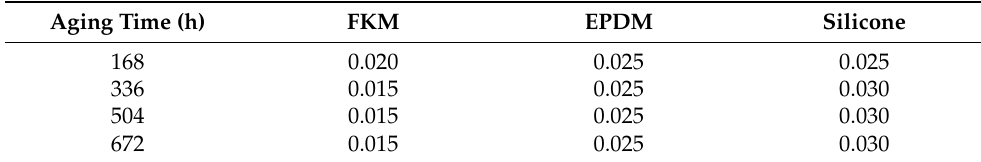
Table 3. Traction speed (in m/s) by material and aging